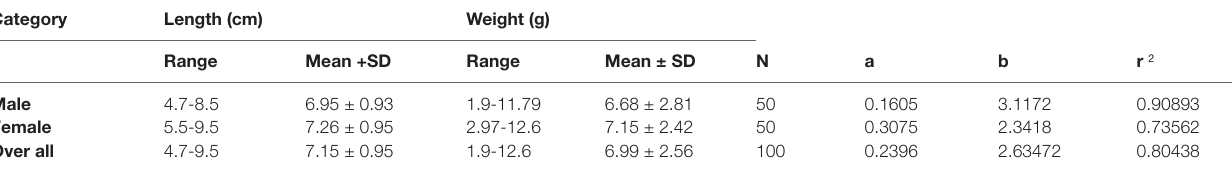
TABLE 4 | Descriptive statistics and estimated parameters of Length-weight relationships for P. maculatus collected from the Korapuzha estuary. Category